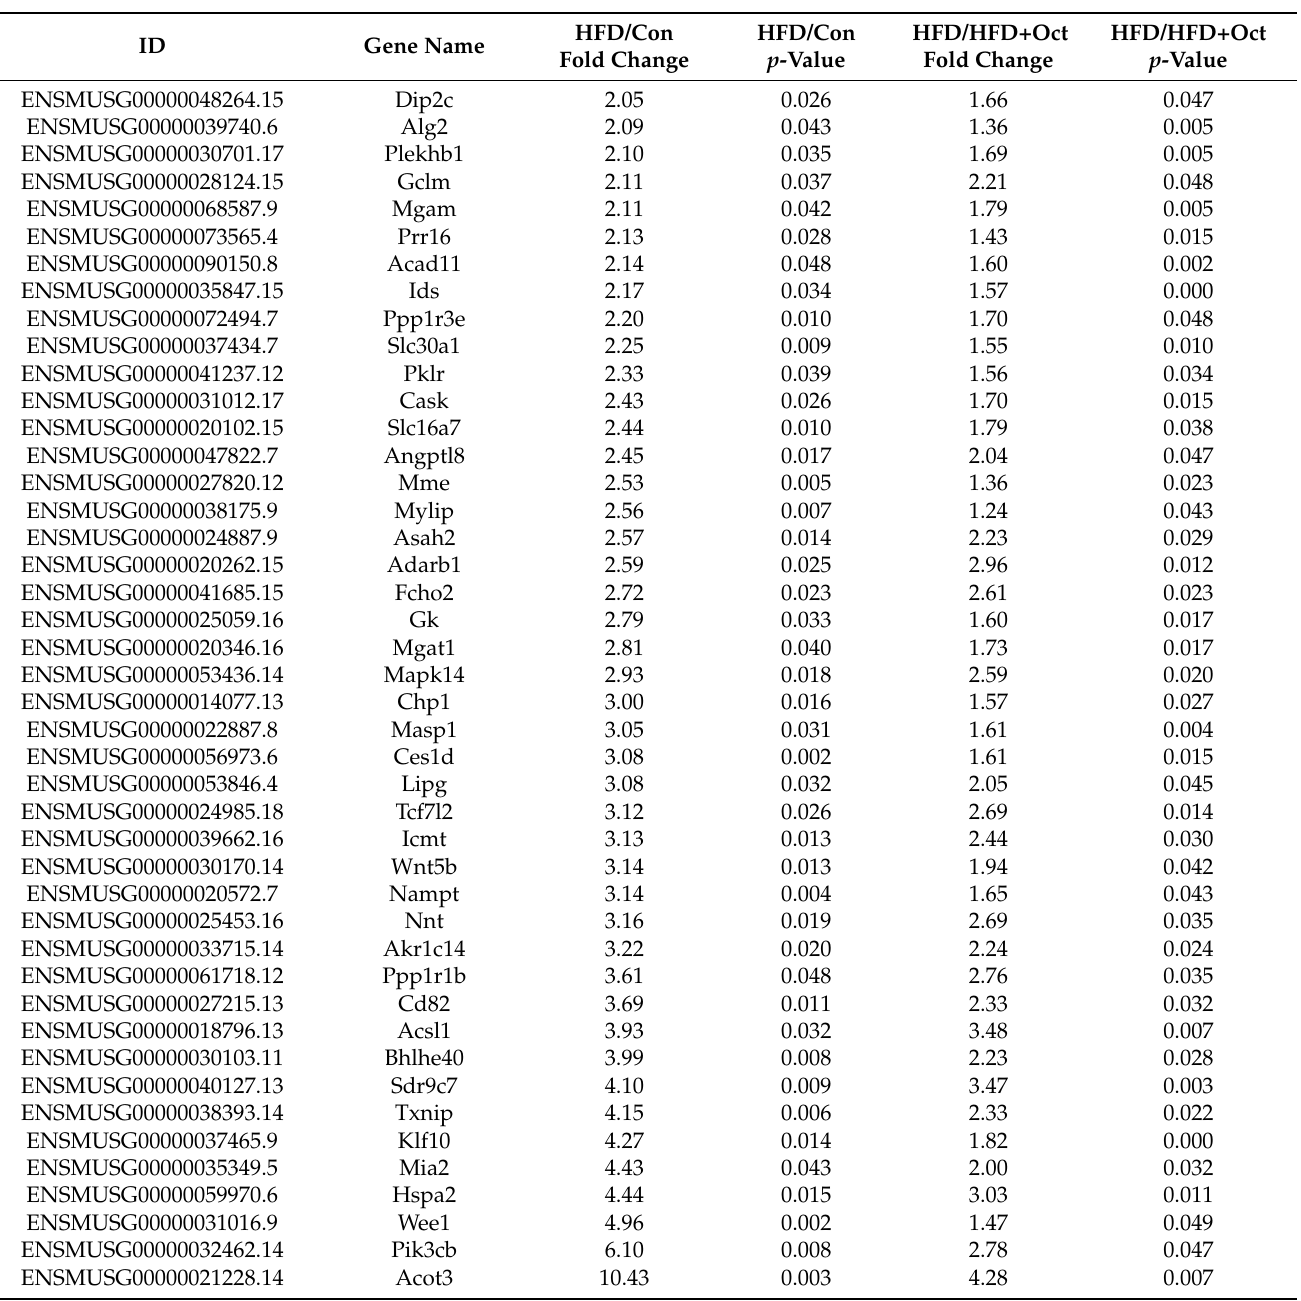
Table 2. Genes down-regulated by Oct from gene chip